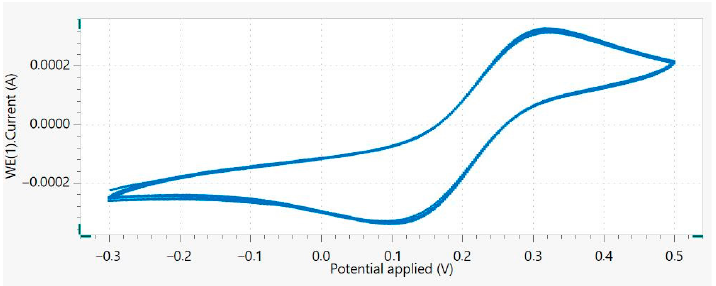
Figure 3. CV voltammogram vs. Ag.AgCl de Fe(CN) 6 5 × 10 − 3 M (in KCl 0.1 M) with electrodes used in non-conventional MFC